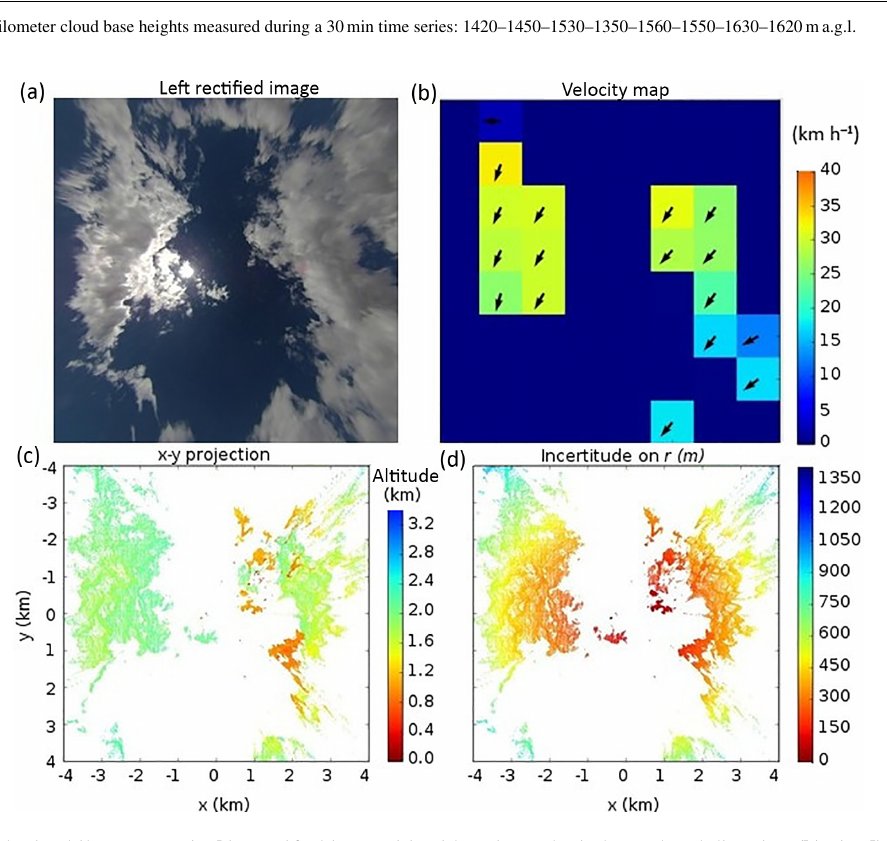
Figure 14. Altocumulus/multilayer case. (a, b) Rectified image (a) with estimated wind speed and direction (b) . (c, d) Triangulated points projected on x − y left camera plane with altitude color map (c) , and with r -incertitude color map (d)